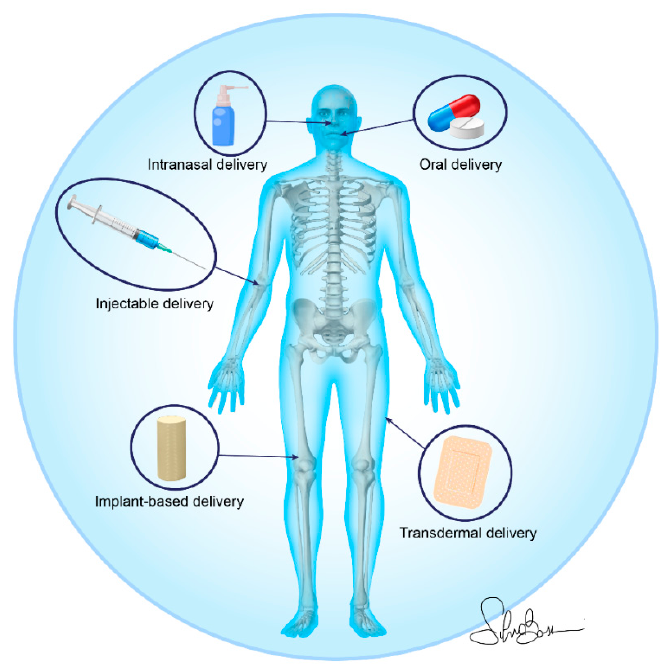
Figure 4. Nano-based material administration strategies for osteoporotic bone drug delivery.